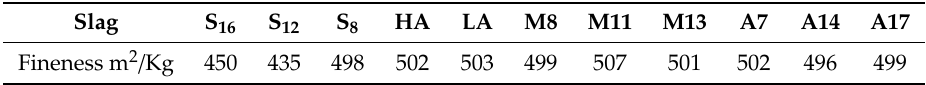
Figure 14. Drying shrinkage results of AASs concretes with reference PC concrete mix. Table 3. The fineness values of the slag used for comparison in Figure 15. S 16 , S 12 , and S 8 are slags used in the present study and remaining slags were used by others